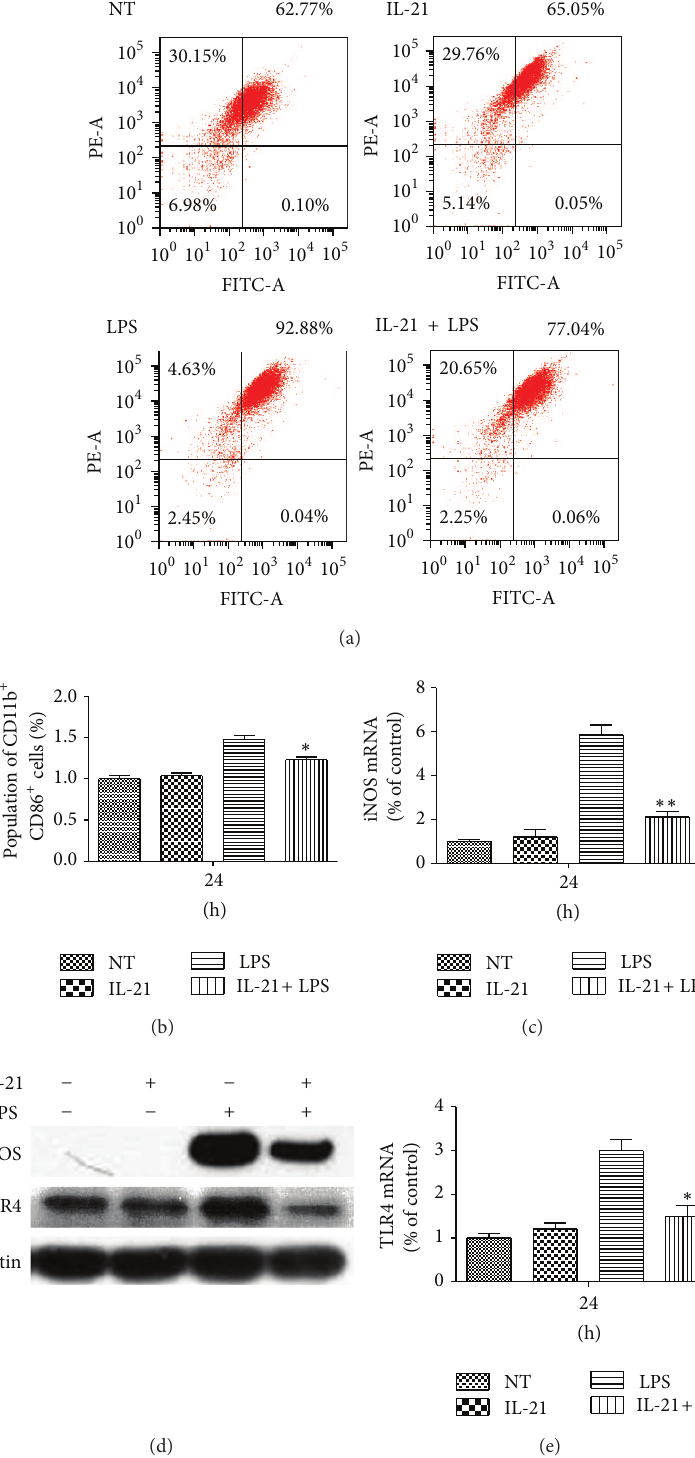
Figure 7: Effects of IL-21 on LPS-induced expression of cell surface markers in mouse peritoneal macrophages. Macrophages ( 1 × 10 6 ) were incubated with IL-21 (100ng/mL) in the presence or absence of LPS (100ng/mL) for 24 h. (a) and (b) Gating strategy used to identify M1 macrophages present in peritoneal macrophages based on surface molecules CD11b and CD86. (c)–(e) Total proteins from macrophages were analyzed by Western blot with specific antibodies. Detection of Actin was estimated as protein-loading control for each lane. Values are presented as mean ± SD of three independent experiments. ∗ 𝑃 < 0.05 , ∗∗ 𝑃 < 0.01 compared with the LPS